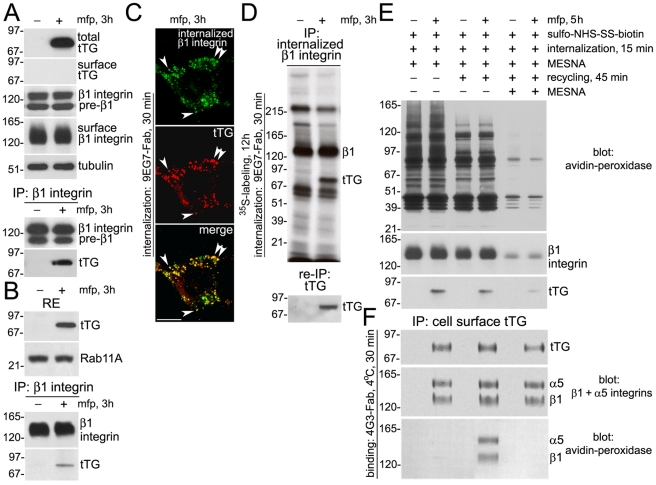
tTG Binds to β1 Integrins Undergoing the Recycling Process Within the Perinuclear Recycling Endosomes.NIH3T3-tTG fibroblasts were induced to synthesize tTG with mifepristone for 3 h (A–D) or 5 h (E,F). (A) tTG forms complexes with β1 integrins prior to secretion. The total levels of tTG, β1 integrins and tubulin were determined by immunoblotting. Cell surface levels of tTG and β1 integrins were defined by labeling cells with sulpho-NHS-LC-biotin, isolation of cell surface proteins on Neutravidin-Agarose, and immunoblotting. β1 integrins were immunoprecipitated from total cell lysates and the resulting immune complexes were probed for β1 integrin and tTG. (B) Recycling endosomes contain the β1 integrin-tTG complexes. Recycling endosomes (RE) were isolated from crude membrane fraction using magnetic beads coated with antibody to Rab11. The levels of tTG and Rab11A in the RE were defined by immunoblotting. β1 integrins were immuno-precipitated from the RE lysates and the immune complexes were probed for β1 integrin and tTG. (C) tTG colocalizes with internalized β1 integrins in perinuclear recycling endosomes. Antibody uptake experiment was performed with surface-bound 9EG7-Fab against the β1 integrin subunit. Digitonin-extracted cells were double-stained for tTG and internalized β1 integrins. Arrows mark colocalization of internalized β1 integrin-9EG7-Fab complexes with tTG on the PNRC vesicles. Immunofluorescence was analyzed by conventional microscopy. Scale bar - 10 µm. (D) The de novo synthesized tTG binds to internalized β1 integrins. tTG synthesis was induced 3 h before the end of metabolic labeling with 35S-Translabel. Antibody uptake experiment was performed with surface-bound 9EG7-Fab against the β1 integrin subunit. Internalized 35S-labeled β1 integrins and associated proteins were analyzed by immunoprecipitation, SDS-PAGE and fluorography. The association of tTG with internalized β1 integrins was confirmed by its reprecipitation from the β1 integrin immune complexes. (E) tTG is associated with the fraction of recycled proteins. Surface labeling and generation of the fractions of internalized proteins, (two left lanes), recycled proteins (two middle lanes), and internalized proteins retained intracellularly after the recycling (two right lanes), were performed as in [44], (see also Materials and Methods). After cell lysis, biotinylated and unlabeled associated proteins in these fractions were isolated on neutravidin-Agarose and β1 integrins and tTG were detected by SDS-PAGE and immunoblotting. (F) Externalized tTG is associated with the recycled α5β1 integrin. The fractions of internalized proteins, recycled proteins, and internalized proteins retained intracellularly after the recycling, were obtained as in (E). Following surface labeling and incubations, 4G3-Fab against tTG was bound to the cell surfaces at 4°C. Surface tTG and associated proteins were immunoprecipitated from cell lysates and the immune complexes were probed by immunoblotting for α5 and β1 integrins and for biotinylated (cell surface-derived) proteins by blotting with neutravidin-peroxidase. Shown in (A,B,D-F) are representative of three independent experiments.